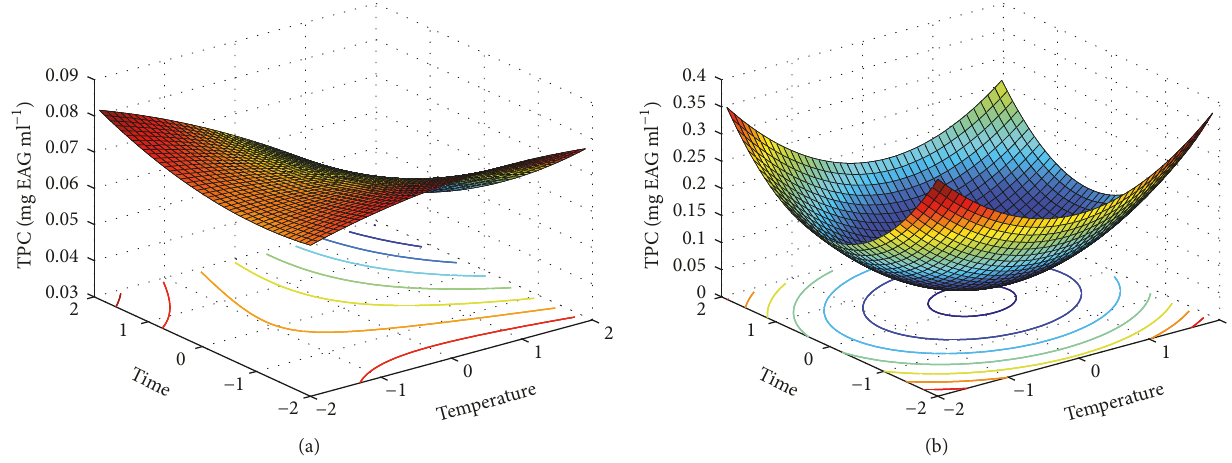
Figure 3: The surface plots of total phenolic content (mg EAG ml −1 ) in aqueous extract (a) and ethanolic extract (b) as affected by roasting time and